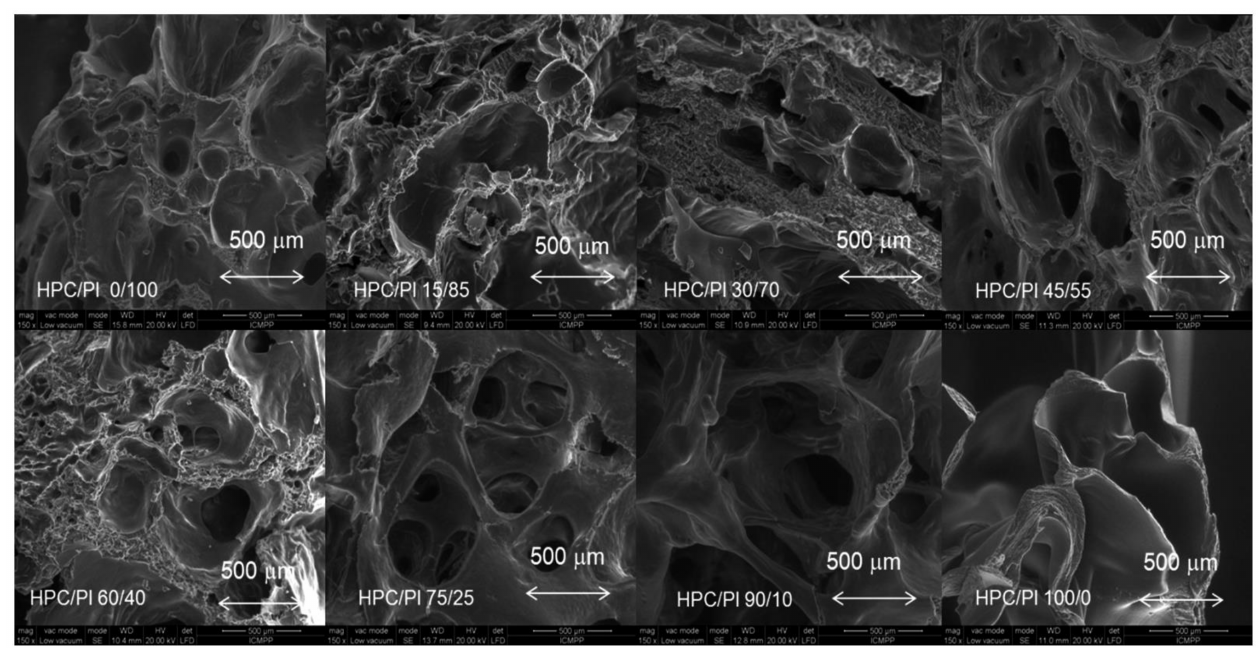
Figure 3. SEM micrographs of the cross-sections of the HPC/Pl blend and pure HPC and Pluronic F68 hydrogel scaffolds.